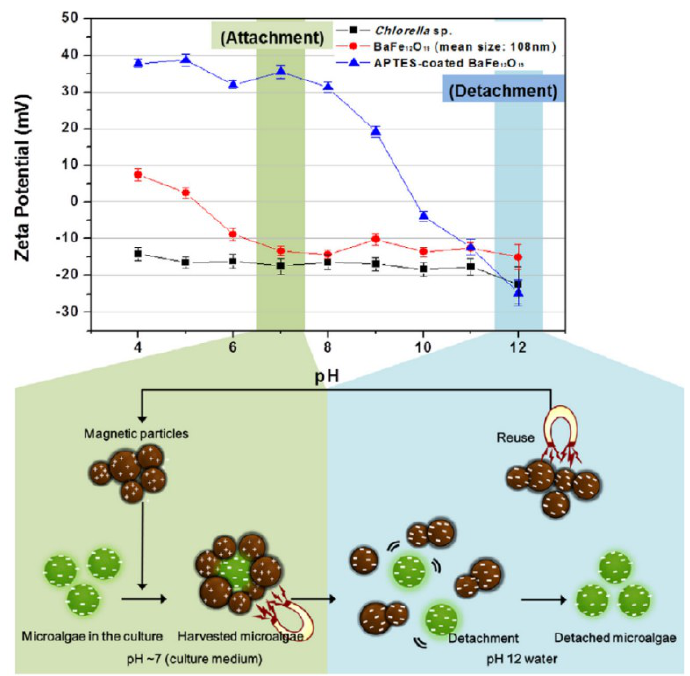
Figure 5. Schematic illustration of magnetic algae harvesting and sequential detaching of BaFe 12 O 19 particles. Reprinted from Reference [103] with the permission of Elsevier.